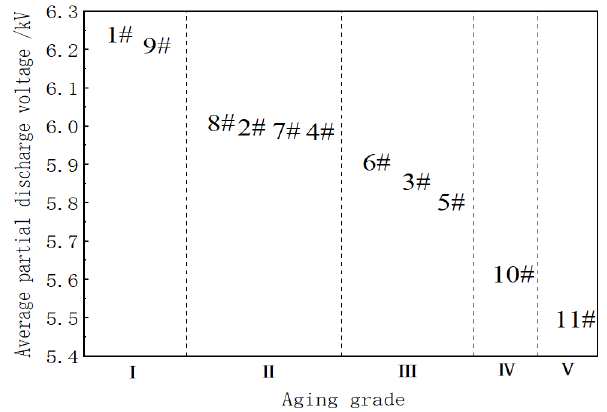
Figure 15. Sort diagram of aging degree of insulator samples.